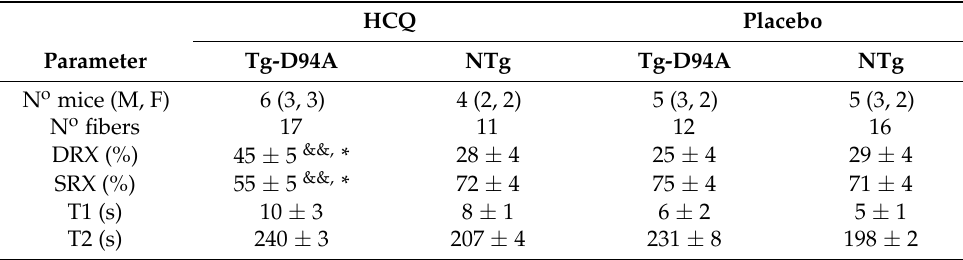
Table 3. Effect of HCQ treatment on myosin energetic states in Tg-D94A vs. NTg hearts. HCQ